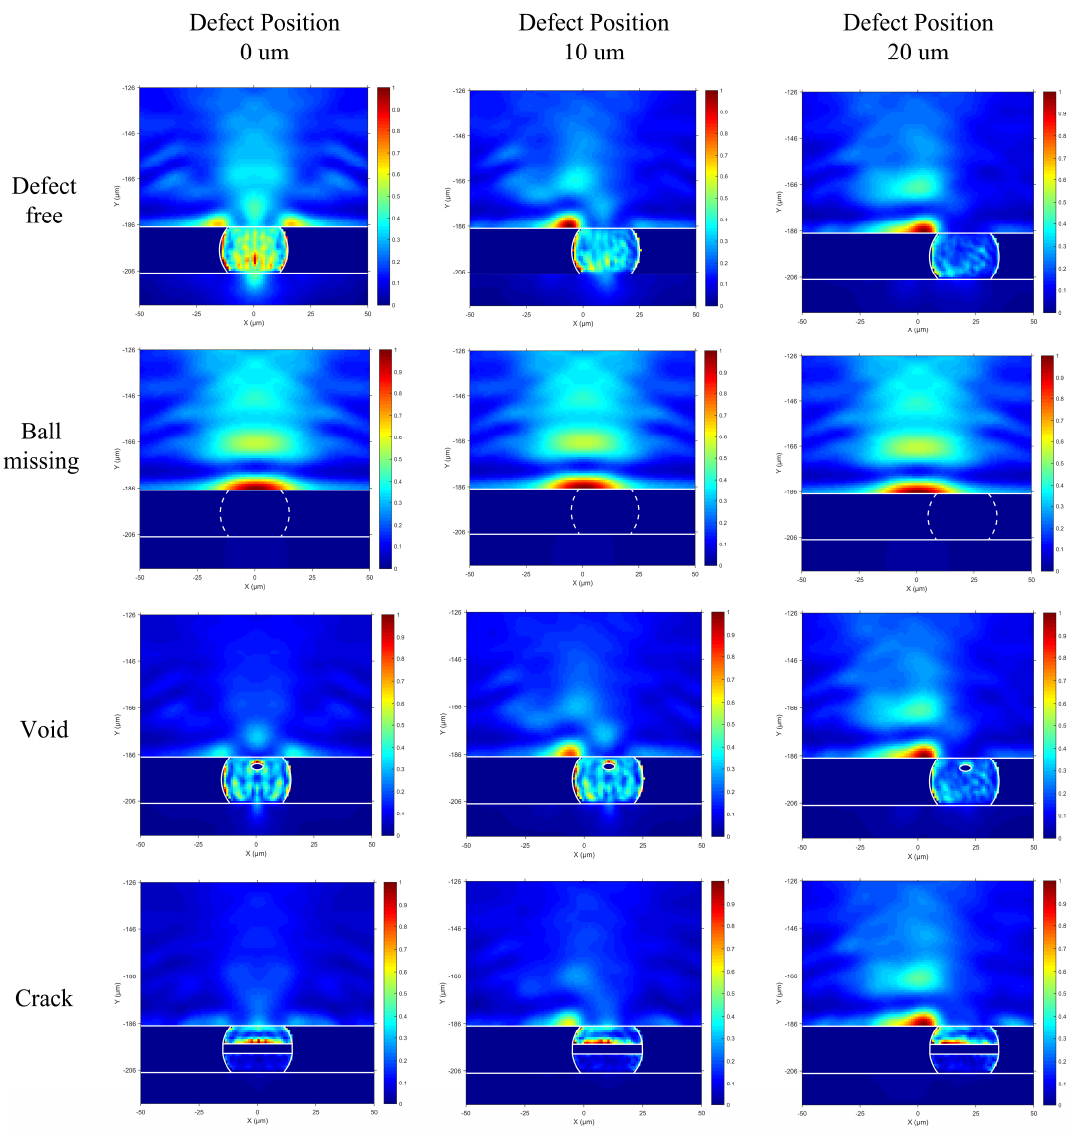
Figure 8. AEFM images of different solder ball defect models.